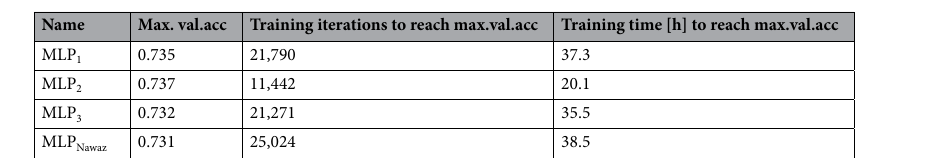
Table 3. Comparison of best models based on the maximum validation accuracy (max. val. acc.) of each MLP architecture.